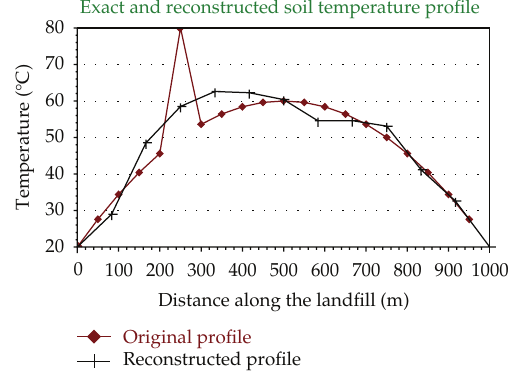
Figure 3: Twelve intervals—Tikhonov’s regularisation factor.